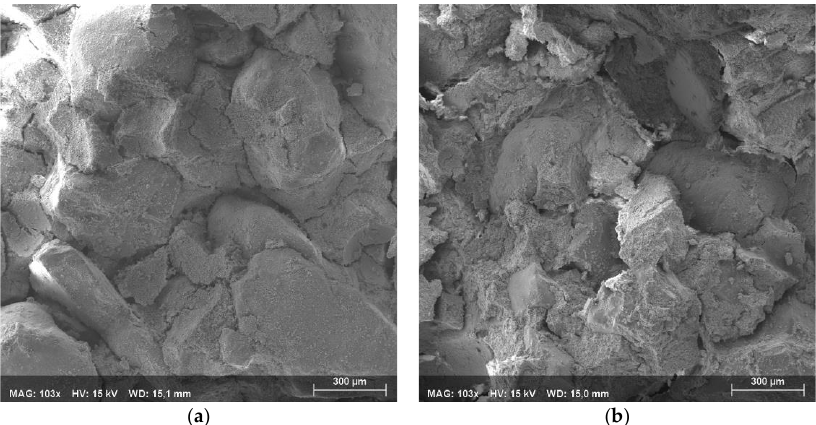
Figure 7. SEM images, at working distance (WD) of 15.0 mm, where it is possible to observe ( a ) the microcracking on the NS mortar; ( b ) compact microstructure of the A+Q30%